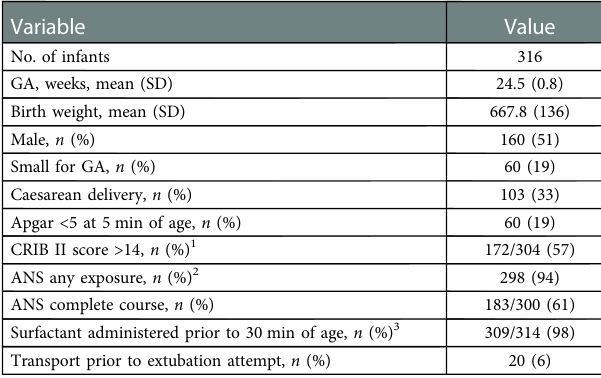
TABLE 1 Characteristics of the study population.